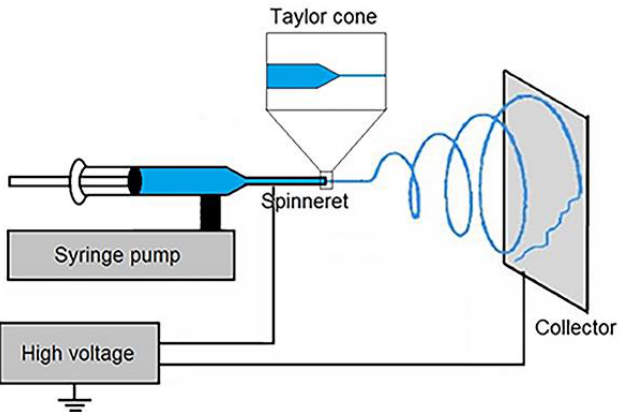
Figure 2. Schematic representation of typical electrospinning system [144] ©2016 Yawen Li and Therese Bou-Akl. Originally published in “Chapter 6 Electrospinning in Tissue Engineering” from Book “ Electrospinning — Material, Techniques, and Biomedical Applications” under Creative Commons Attribution License (http://creativecommons.org/licenses/by/3.0, accessed on 4 December 2022). Available from: https://doi.org/10.5772/65836, accessed on 4 December 2022.